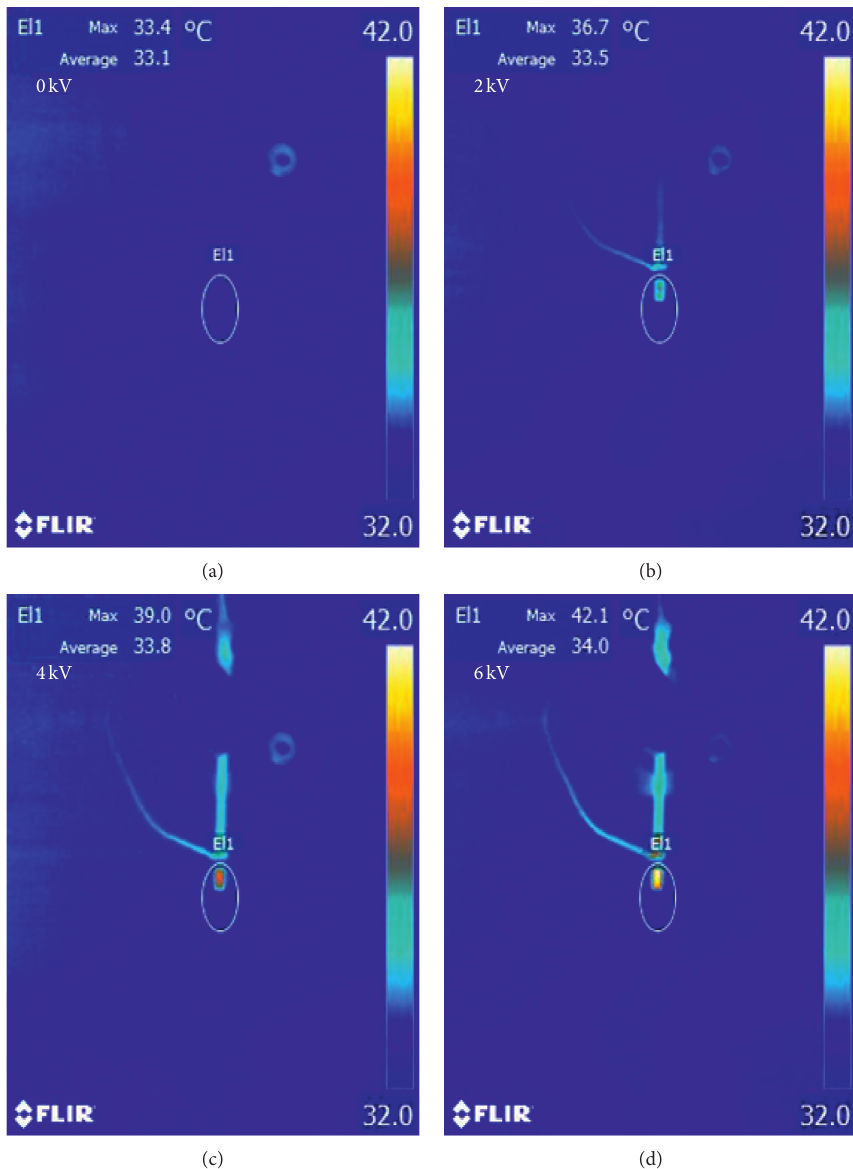
Figure 7: Temperature thermogram of the He-plasma jet at different applied